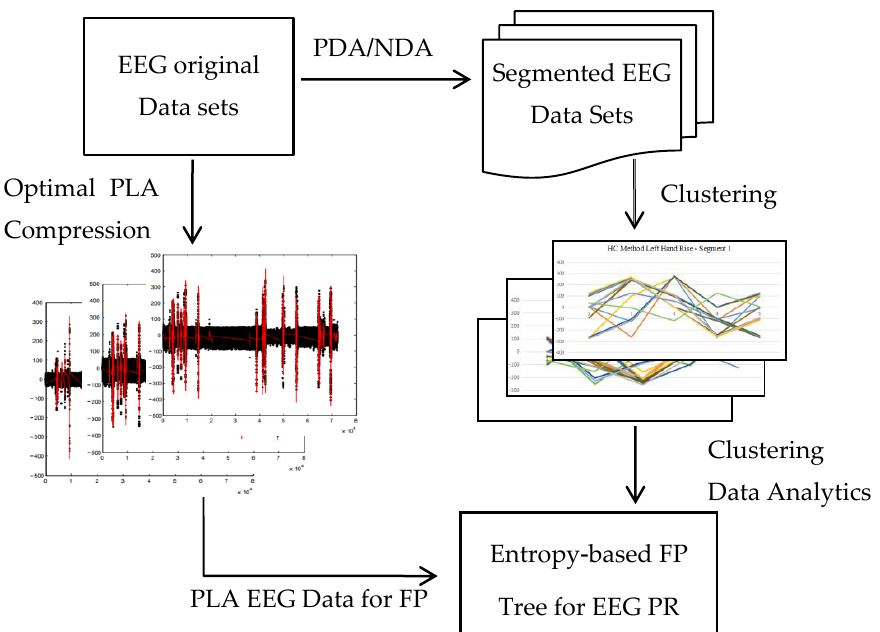
Figure 5. EEG self - adjusting analytical process - FP(Frequent Pattern), PR(Pattern Recognition), Figure 5. EEG self-adjusting analytical process - FP (Frequent Pattern), PR (Pattern Recognition), PLA PLA(Piecewise Linear Approximation) . (Piecewise Linear Approximation). Table 2. Left - hand rise EEG data clustering centroids .